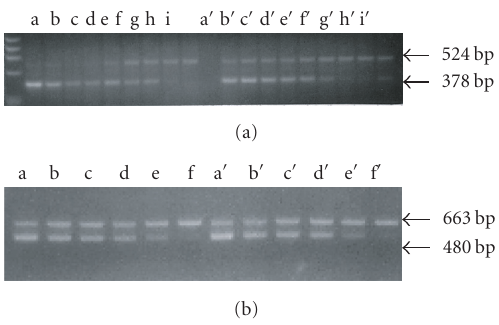
Figure 6. Quantitative competitive PCR on cultured cells. (a) 6A3-5 RT-PCR done on P9 (a, b, c, d, e, f) and V8 cells (a (cid:1) , b (cid:1) , c (cid:1) , d (cid:1) , e (cid:1) , f (cid:1) ). We have, in P9 cells, 1–2 pg of 6A3-5 in 50ng of total RNA whereas it is 7.5–10 pg, in V8 cells. Molecular weight di ff erence between normal and recombinant 6A3-5 RNAs is 146 bp (the competitor RNA is 378 bp whereas the normal RNA is 524 bp). aa (cid:1) , bb (cid:1) , cc (cid:1) , dd (cid:1) , ee (cid:1) , ff (cid:1) , gg (cid:1) , hh (cid:1) , ii (cid:1) = 25, 20, 15, 10, 5, 2, 1, 0.5, and 0.1 pg, respectively. (b) Actin RT-PCR. Both P9 and V8 cells have 40 pg of actin in 10 ng of total RNA. Molecular weight di ff erence between normal and recombinant RNAs, used in the quantification, is 183 bp (the competitor RNA is 480 bp whereas the normal RNA is 663 bp). aa (cid:1) , bb (cid:1) , cc (cid:1) , dd (cid:1) , ee (cid:1) , ff (cid:1) = 75, 50, 40, 35, 30, and 20 pg, respectively.